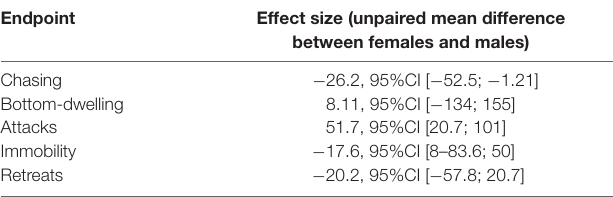
TABLE 1 | Endpoints and effect sizes (unpaired mean differences between female and male individuals) in the observation session made on the 5th day of hierarchy formation across